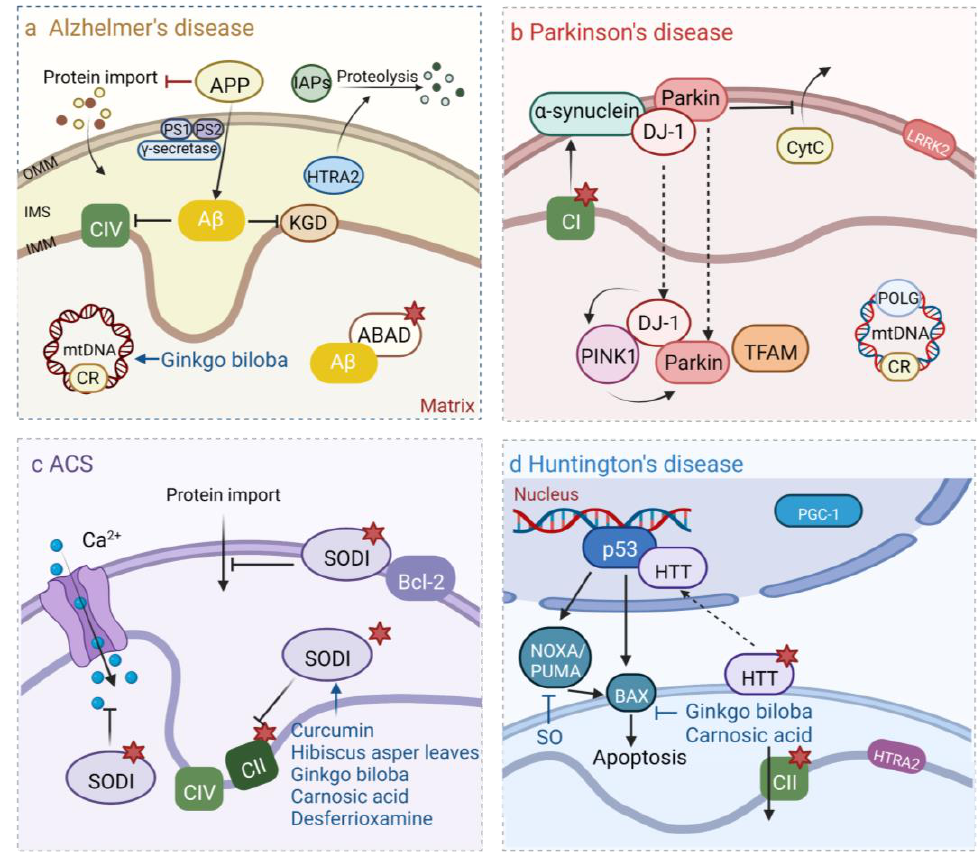
Figure 5. Mechanisms of mitochondria in four common neurodegenerative diseases. ( a ) In AD, Amyloid precursor protein (APP) can affect protein input by targeting OMM. APP is cleaved by γ -secretase complex to form A β . A β inhibits mitochondrial electron transport chain complex CIV and α -ketoglutarate dehydrogenase (KGD) and binds to A β -binding alcohol dehydrogenase (ABAD). A β increased the proteolytic activity of HTRA2 to IAPs. ROS were produced by both KGD and ABAD (red stars). MtDNA mutations increased in AD. ( b ) Mutations in complex I and POLG encoded by mtDNA are also pathogenic factors in PD. Overexpression of α -synuclein can impair mitochondrial function. Parkin is associated with mitochondrial transcription factor A (TFAM), which binds to OMM and inhibits the release of CytC. During oxidation, DJ-1 moves to mitochondrial IMS and stroma, and mitochondrial kinase PINK1 acts with DJ-1 and Parkin to protect cells. Kinase LRRK2 can be localized to OMM. ( c ) In ALS, the overexpression of mutant SOD1 can affect the concentration of Ca 2+ in mitochondria, protein transport, and ATP production. Mutant SOD1 promotes the abnormal production of mitochondrial ROS and reduces the mutational activity of the neuronal mitochondrial complex CII. ( d ) In HD, the mutant HTT translocated to the neuron nucleus and promoted the transcriptional activity of p53, which activated the proapoptotic factor BAX either directly or by promoting the expression of NOXA and PUMA. In addition, HTRA2 mutations are also a cause of HD. In this process, natural plant-derived products have different